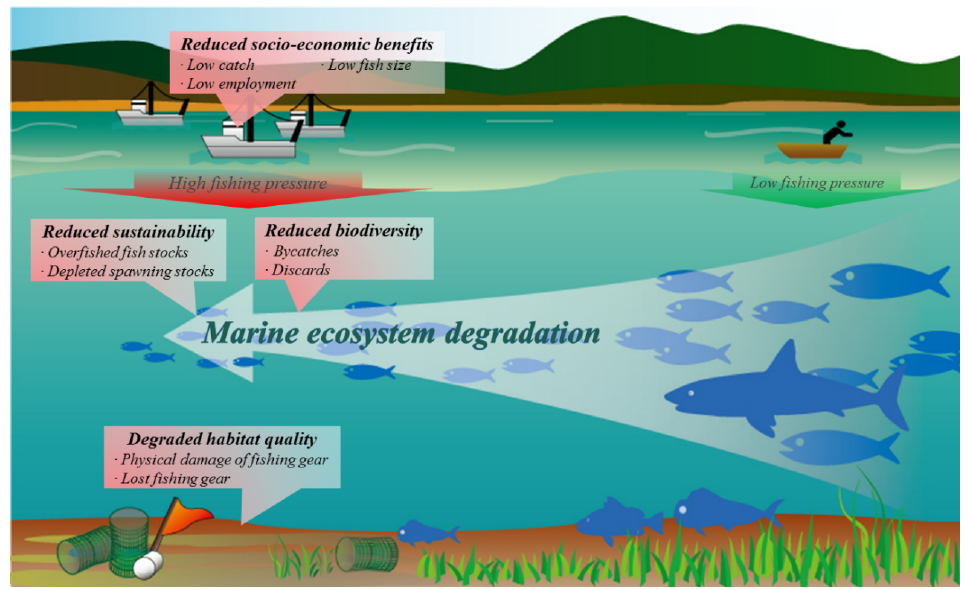
Figure A1. The ecological impacts of the driving force of capture fisheries on the fishery resources and their ecosystem. Table A1. Indicators for capture fisheries activities in the extended EBFA (employed from the previous EBFA [9,10]). Management